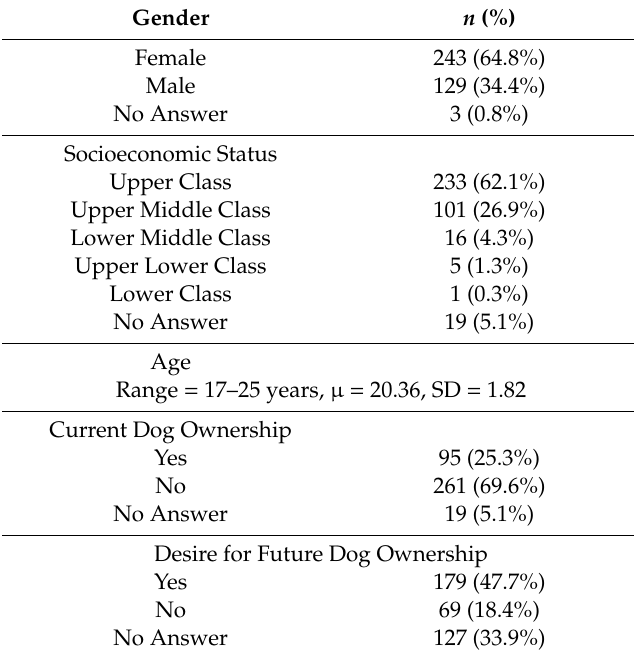
Table 1. Demographic data of survey